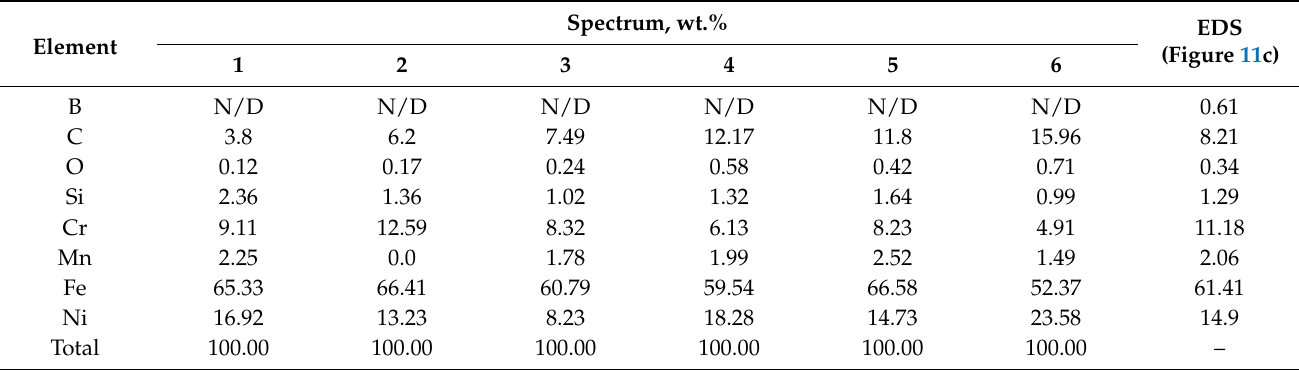
Table 5. The composition of the spectra. Spectrum,